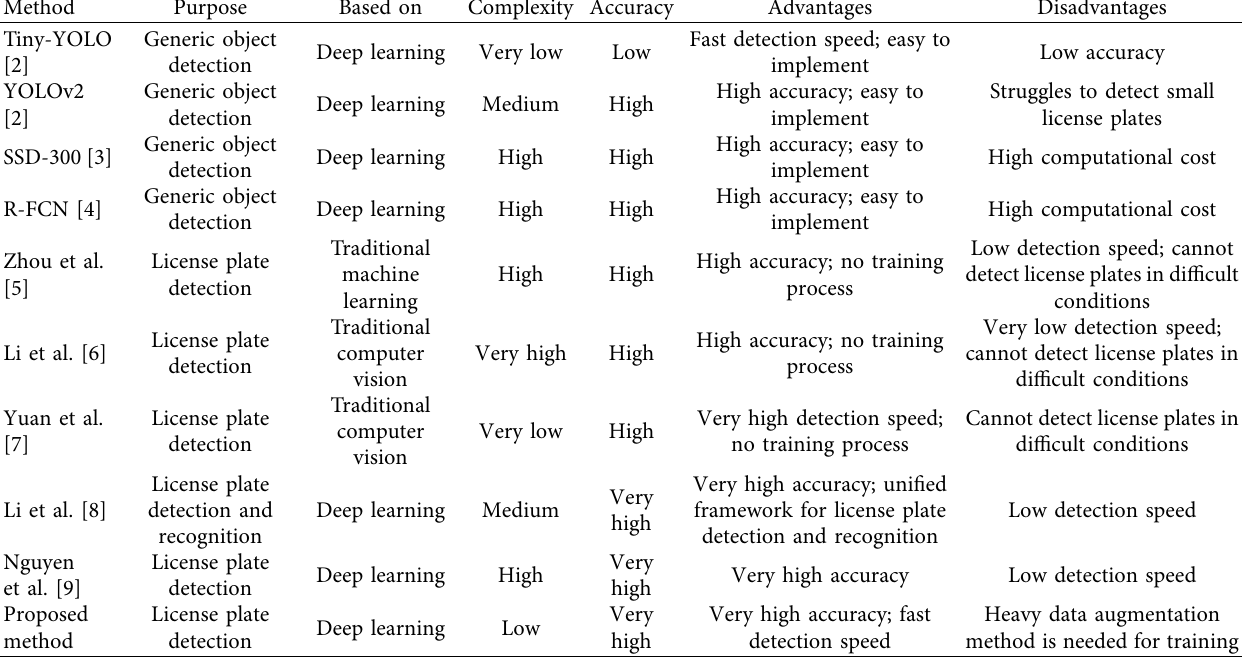
Table 1: Summary of features of the proposed method and recent methods for license plate